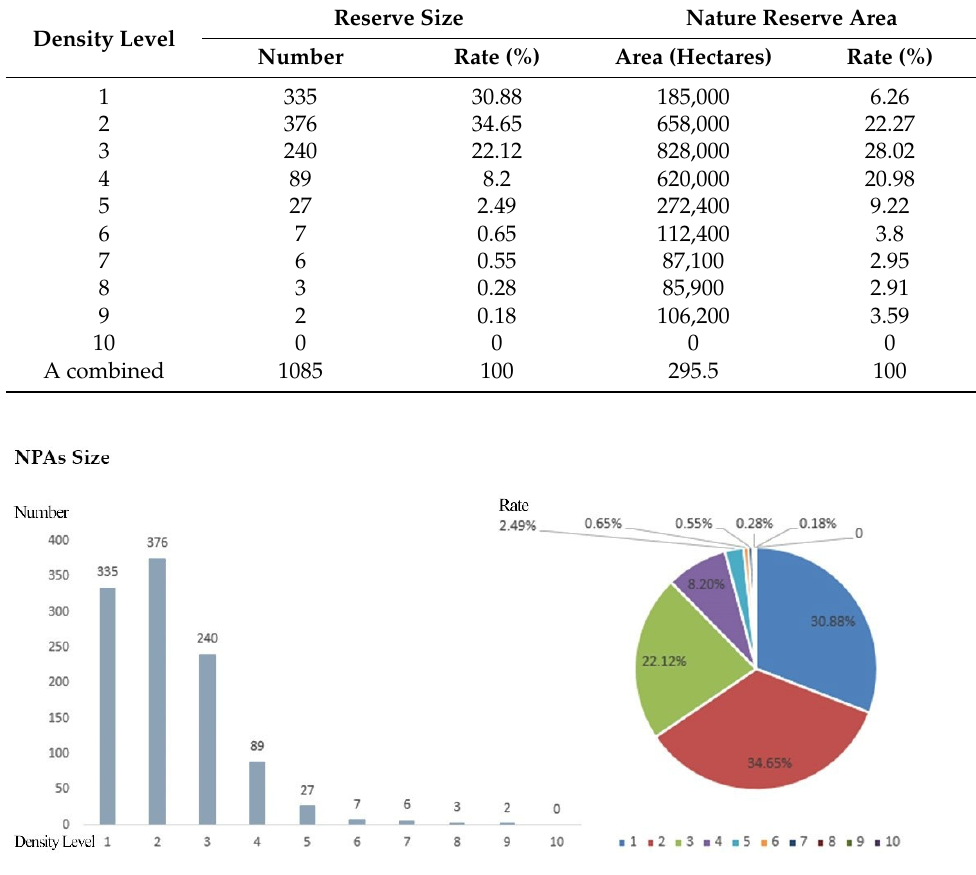
Table 3. Statistics regarding the number and area of NPAs at different levels.